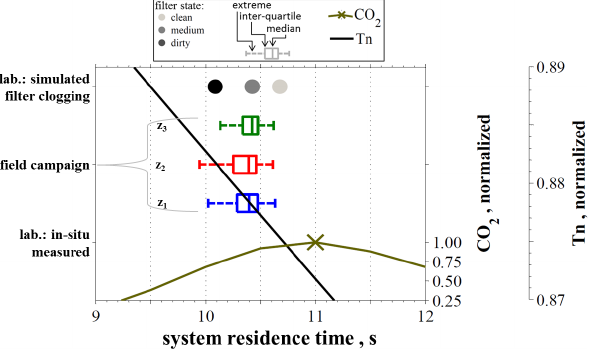
Fig. 6. Time series of Tn and Rn concentrations during sixteen days of side-by-side measurements (10–26 October 2011) measured with the RAD7 monitors (60min integration time). After the zero air measurement (1) we purged the chamber with 70Lmin − 1 (2), 35Lmin − 1 (3), and 5Lmin − 1